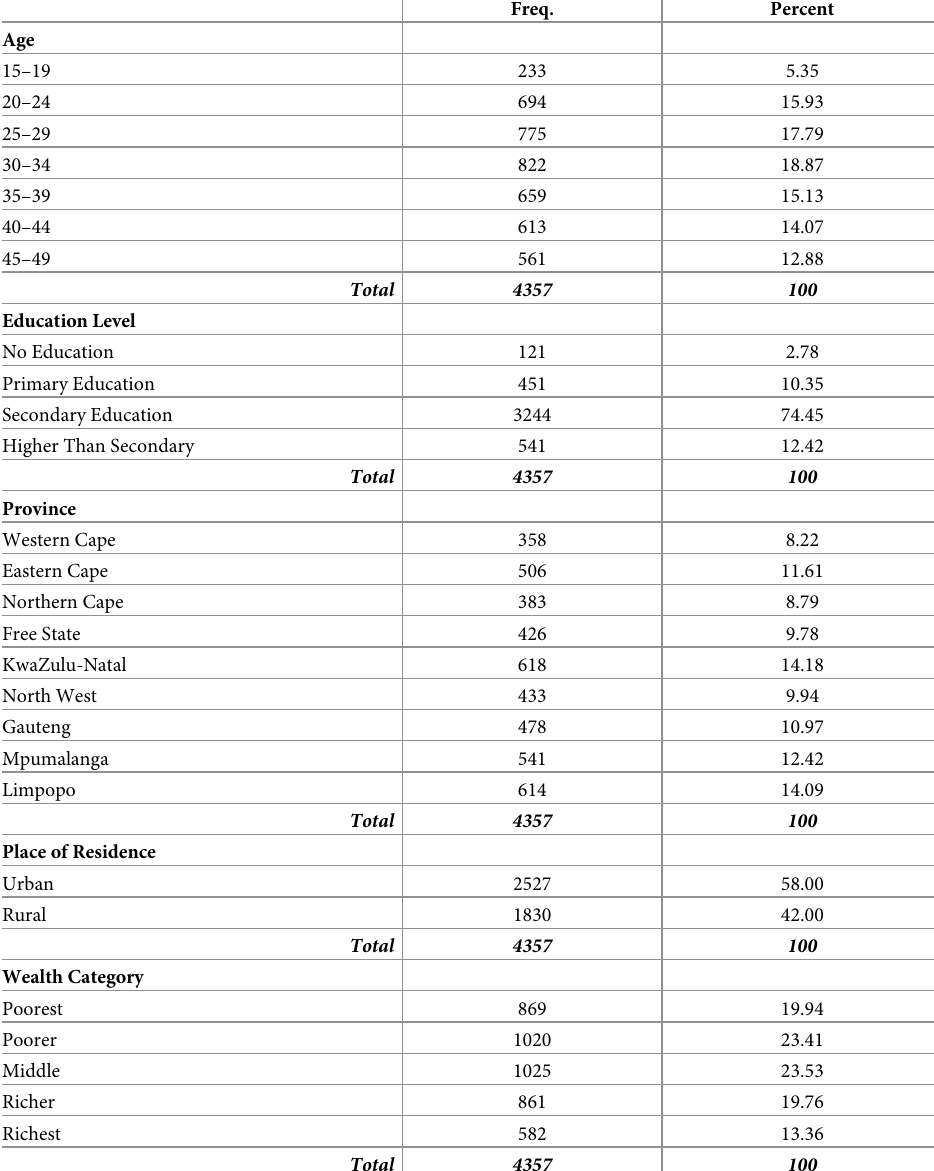
Table 2. Percentage and frequency distributions of South African women of reproductive age by selected socio- demographic factors.